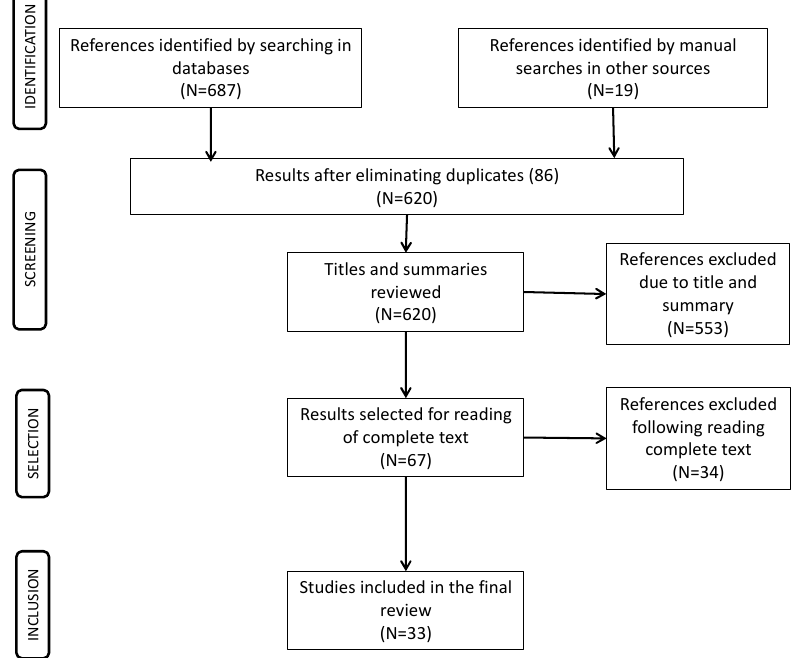
Figure 2. PRISMA figure. Results of the literature review.